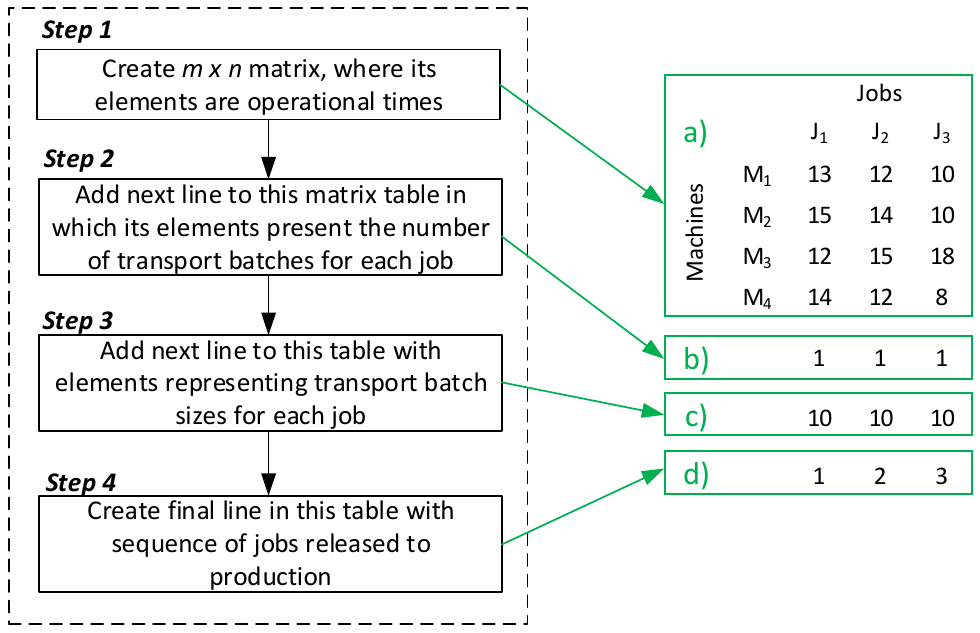
Figure 2. Table format for insertion of input data, ( a ) processing times in minutes for each job, which are included in matrix m x n , ( b ) number of transport batch, ( c ) transport batch sizes for each job, ( d ) sequences of individual jobs numbered by order.